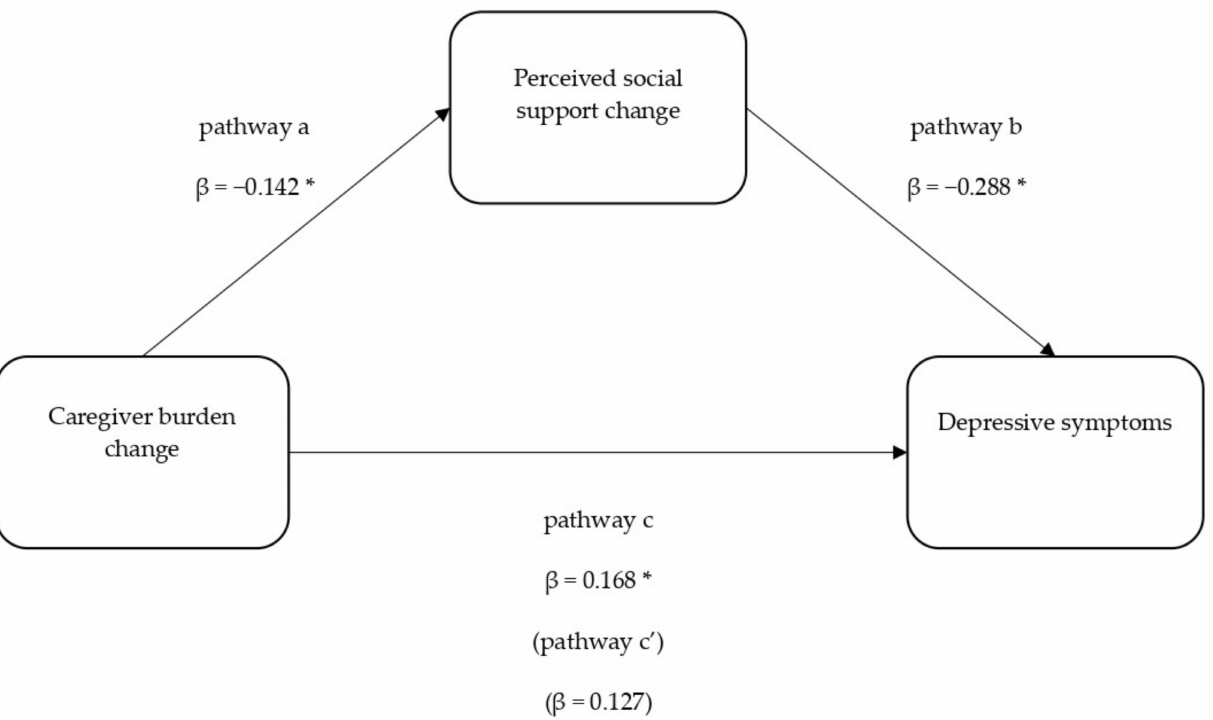
Figure 2. Mediation model of caregiver burden change and depressive symptoms through perceived social support change. * p <